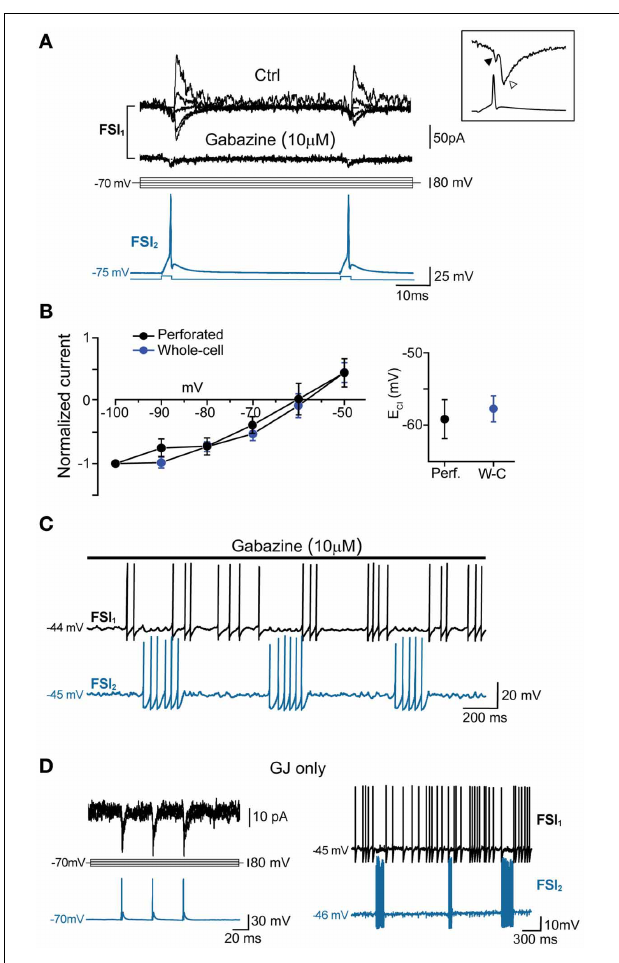
FIGURE 5 | GABA A -mediated fast synaptic transmission is not required for spike inhibition. (A) GABAergic IPSCs (top) evoked in FSI 1 at various holding potentials (from − 100 to − 20mV, 10-mV steps; middle) in response to two consecutive AP elicited in FSI2 at an interval of 50ms (bottom). In pairs connected by GABAergic synapses, mean peak amplitude, 10–90% rise time, and decay time constant of unitary IPSCs (recorded in voltage-clamp mode at V clamp = − 90mV) were − 70 ± 14pA, 0.6 ± 0.08ms, and 3.7 ± 0.5ms, respectively, while the mean paired-pulse ratio was 0.85 ± 0.05. Bath application of 10 μ M gabazine for 5–10min completely blocked the IPSCs, unmasking small GJ-mediated currents. Inset, magnification of I GJ (black arrowhead) followed by I GABA (white arrowhead) recorded at − 100mV in response to an individual presynaptic AP (bottom trace) (B) Left, current-voltage plots of IPSC amplitudes (mean ± s.e.m.) normalized to average values recorded at − 100mV. Blue and black traces represent data obtained with whole-cell ( n = 15) and perforated patch recordings ( n = 4), respectively. Right, summary plot of average reversal potentials for Cl − ions ( E Cl ) obtained with perforated patch ( − 59 . 6 ± 3mV, n = 4) and whole-cell recordings ( − 58 . 2 ± 2mV; n = 15). The theoretical E Cl calculated using the Nernst equation in our experimental conditions was − 59mV (see Methods). (C) Example of spike series in which inhibition is still evident during application of 10 μ M gabazine. (D) Left, voltage-clamp recordings of spikelets alone (i.e., without superimposed IPSCs) at various command potentials in response to three presynaptic AP (blue trace) in a pair connected by GJ, but not GABAergic synapses. Right, mutual inhibition of firing activity recorded in the same pair.